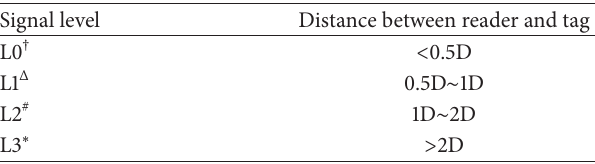
Table 1: Levels of signal strength.